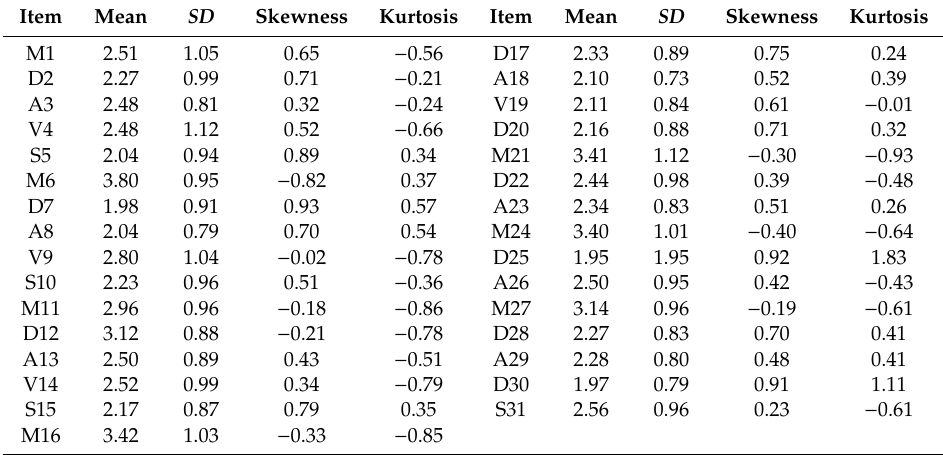
Table 1. Descriptive statistics, skewness and kurtosis for the SCS-American English (SCS-AE) 31